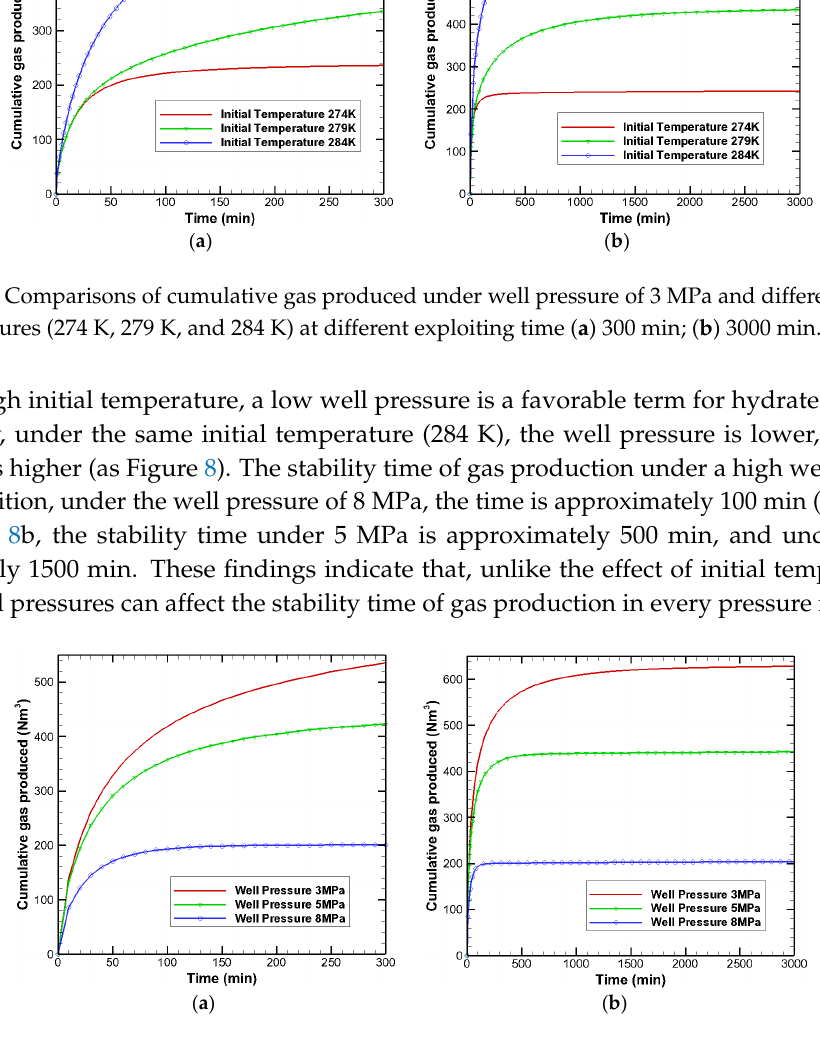
Figure 8. Comparisons of cumulative gas produced under initial temperature of 284 K and different well pressures (3 MPa, 5 MPa, and 8 MPa) at different exploiting time ( a ) 300 min; ( b ) 3000